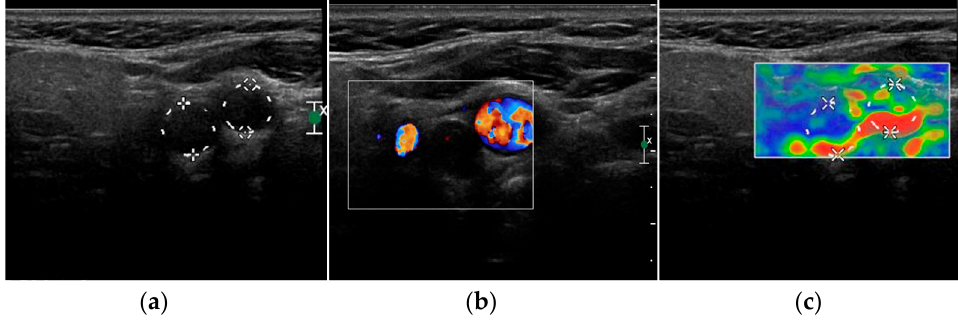
Figure 4. Grey-scale ( a ), Color Doppler ( b ) and elastography ( c ) aspect of a carotid body paraganglioma.